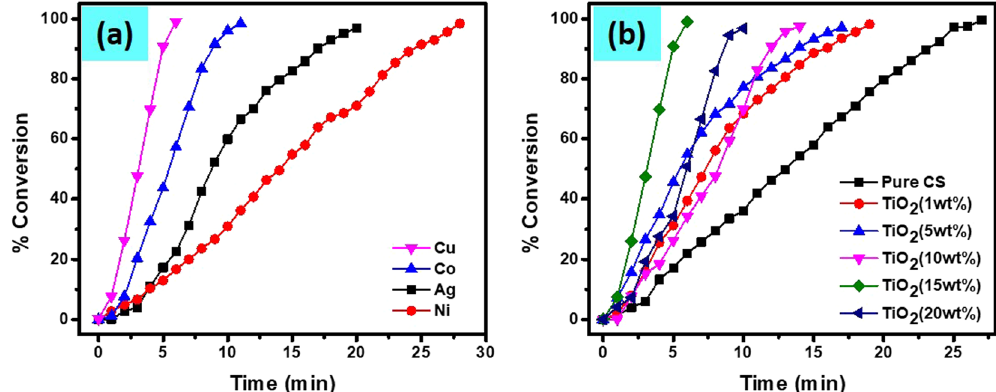
Figure 10. Percent conversion of 4-NP to 4-AP in the presence of catalyst, CS-TiO 2 -15 templated with Cu, Co, Ag and Ni NPs ( a ), and in the presence of Cu-NPs loaded on pure CS and added TiO 2 of 1 wt%, 5 wt%, 10 wt%, 15 wt% and 20 wt% nanocomposite.